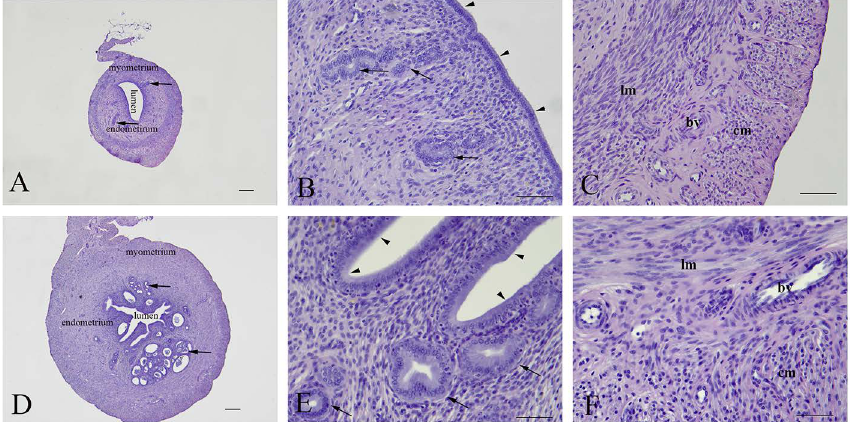
Figure 3. Representative micrographs of uterine cross sections. ( A – C )—Early miscarriage; ( D – F )—late miscarriage. Arrowheads—luminal epithelium; Arrows—endometrial glands; lm—longitudinal and cm—circular muscle layers; bv—blood vessels. ( A , D )—bar = 200 µ m; ( B , C , E , F )—bar = 50 µ